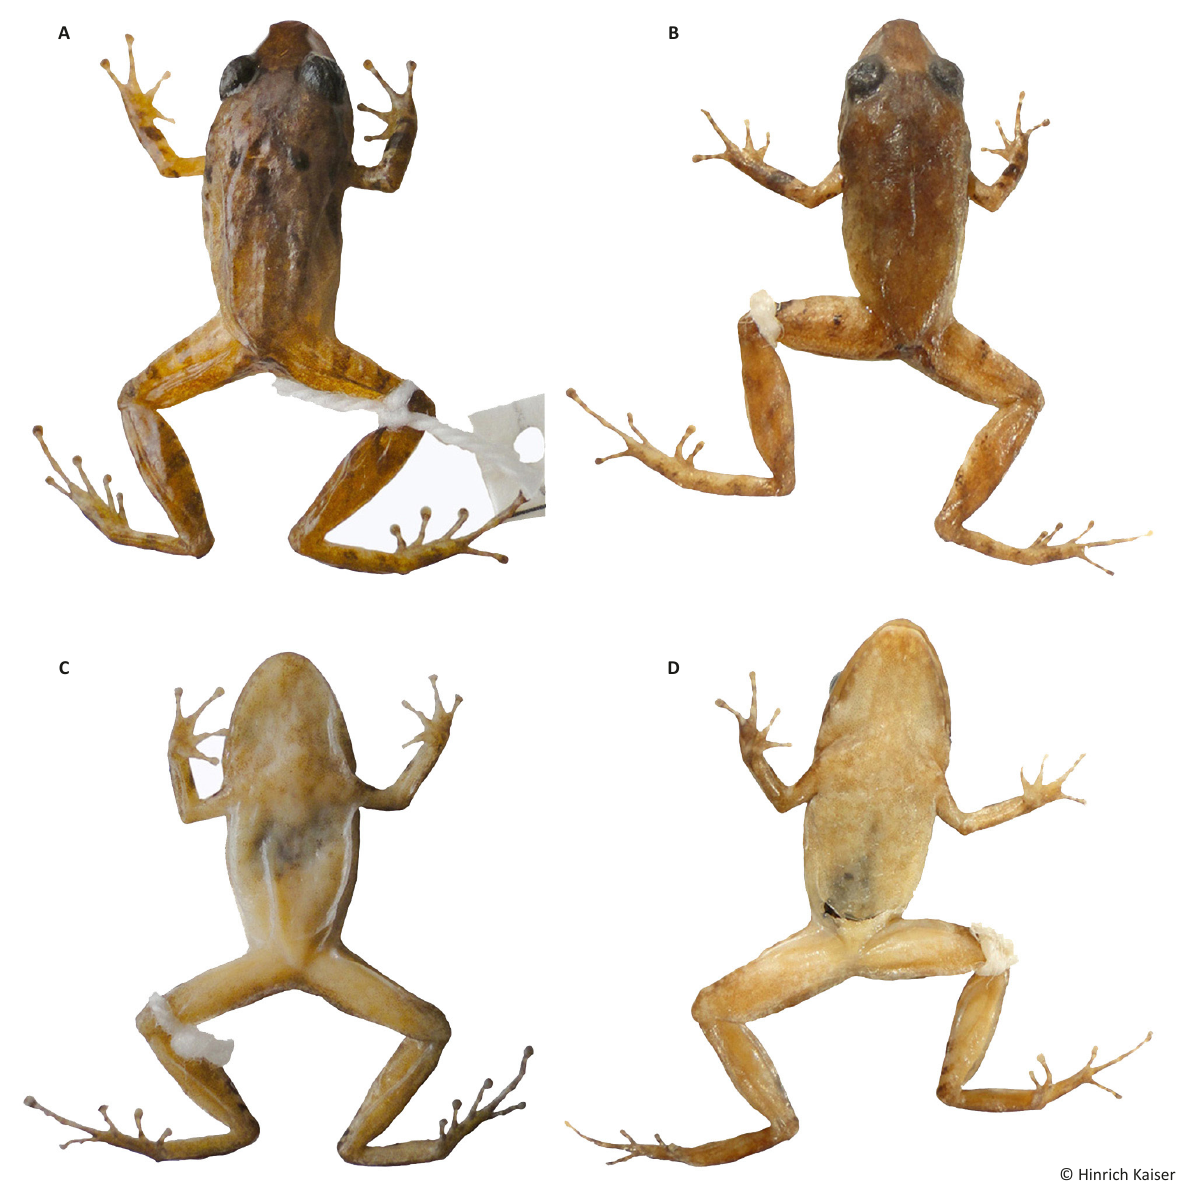
Image 13. Dorsal and ventral pattern variation of Pristimantis geminus sp. nov., illustrating the overall relatively plain coloration. It is noteworthy that the scapular spots are still easily visible in the holotype (A; USNM [CMD 341], male, SVL = 20.8mm) but have faded considerably in the paratopoptype (B; CVULA 7443, male, SVL = 16.9mm). In contrast, the middorsal raphe is more readily apparent in the paratopotype (B) than in the holotype (A). The ventral coloration is relatively plain, with the profusion of melanophores darkening the appearance of the